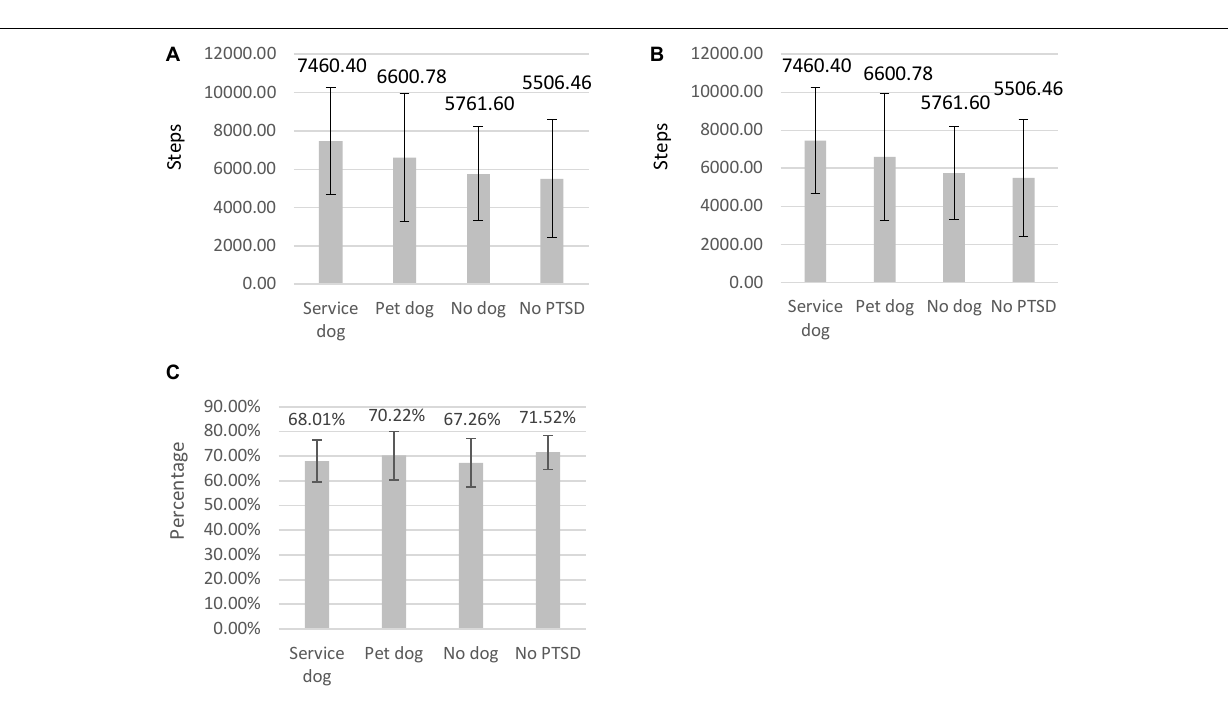
FIGURE 2 | The number of steps taken during 24 h (A) , mean step time (B) , and percentage stillness (C) per participant group. The four groups are: individuals with PTSD and a service dog ( n = 15), individuals with PTSD and a companion dog ( n = 9), individuals with PTSD without a dog ( n = 10), Individuals without PTSD ( n =